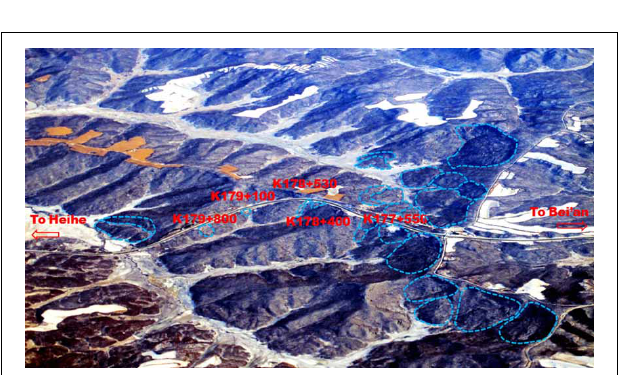
FIGURE 6 | Full view of K175 + 500 - K180 + 200 section of Bei’an-Heihe Highway (Blue line is the boundary of the landslides, the orange area is corn field).